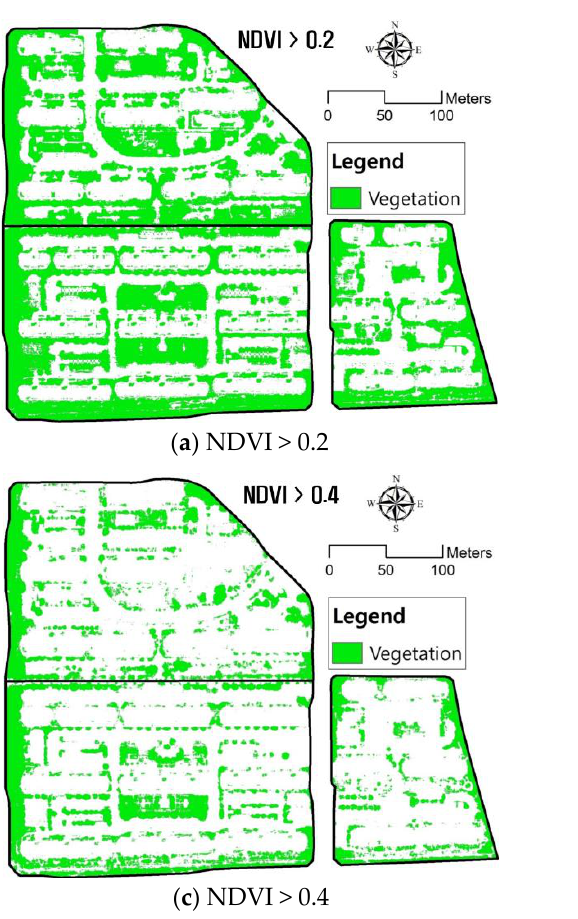
Figure 10. NDVI map analyzed by UAV-based multispectral image. Table 5. Statistical value of NDVI map. Vegetation Index